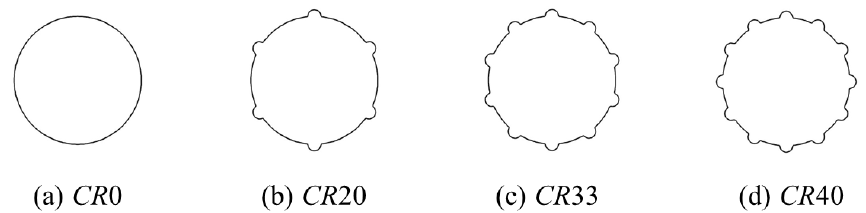
Figure 2. Schematic diagram of a cylinder with different coverage ratios.